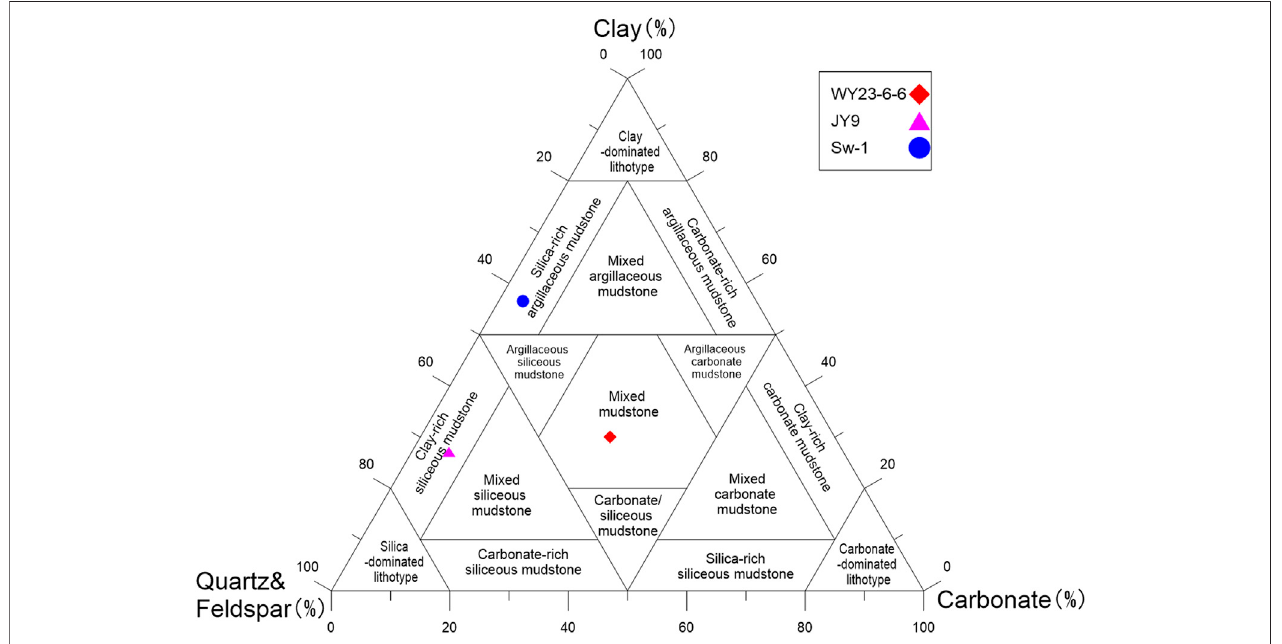
FIGURE 2 | Classi fi cation scheme for organic-bearing mudstones based on bulk mineralogies for the three shale samples (after Gamero – Diaz (Diaz, 2012)).